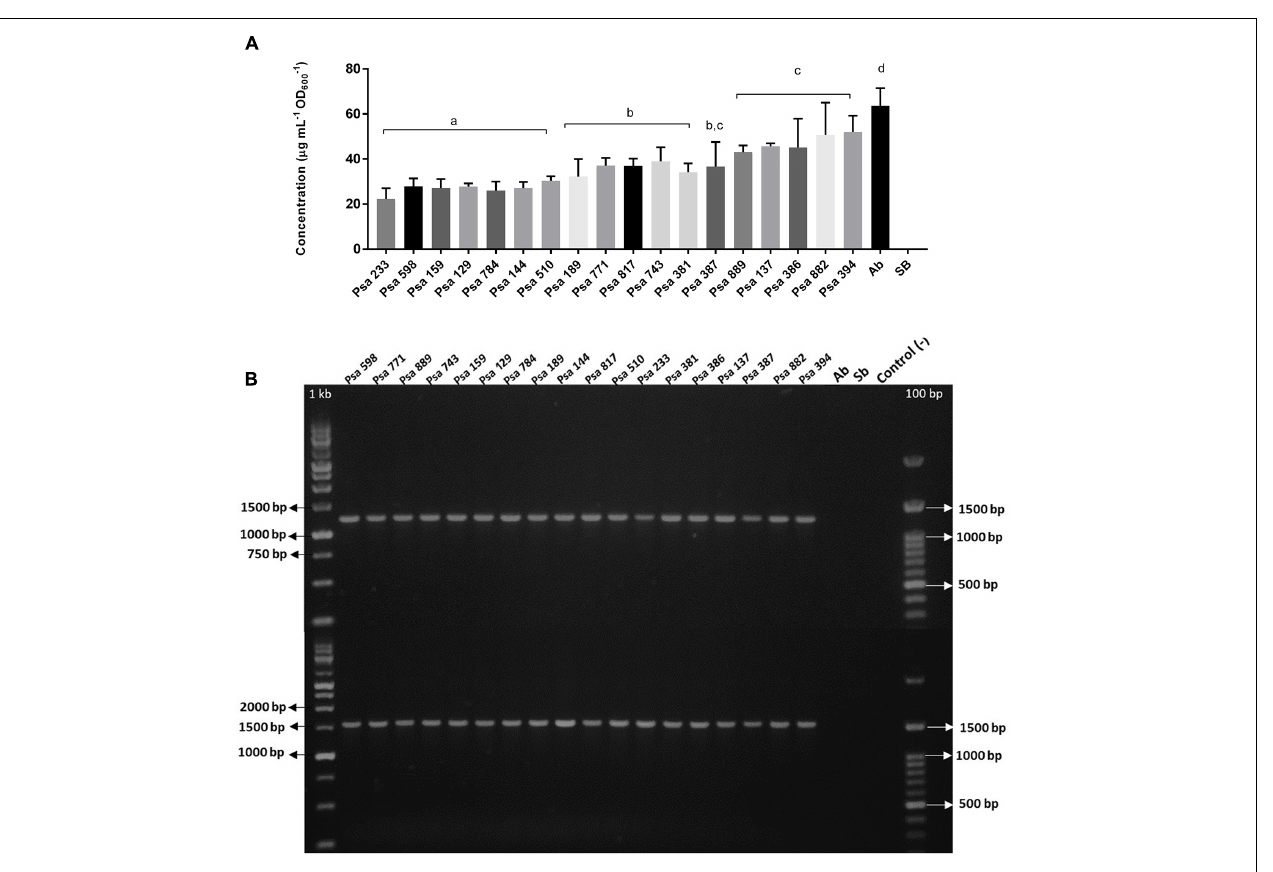
FIGURE 4 | Indole production and detection of iaaL/matE genes in the Chilean Psa isolates. (A) Indole produced by the Chilean Psa isolates. Bacterial strains are organized according their level of indole production, and letters (a–d) show significant differences ( p ≤ 0.05). The calibration curve with IAA (Sigma) is shown in Supplementary Figure S3 . (B) PCR detection of genes iaaL (top) and matE (bottom). Molecular markers: 1 kb and 100 bp. Control (–): Reaction without DNA. A. brasilense (Ab) and S. bongori (Sb) were used for the positive and negative controls,